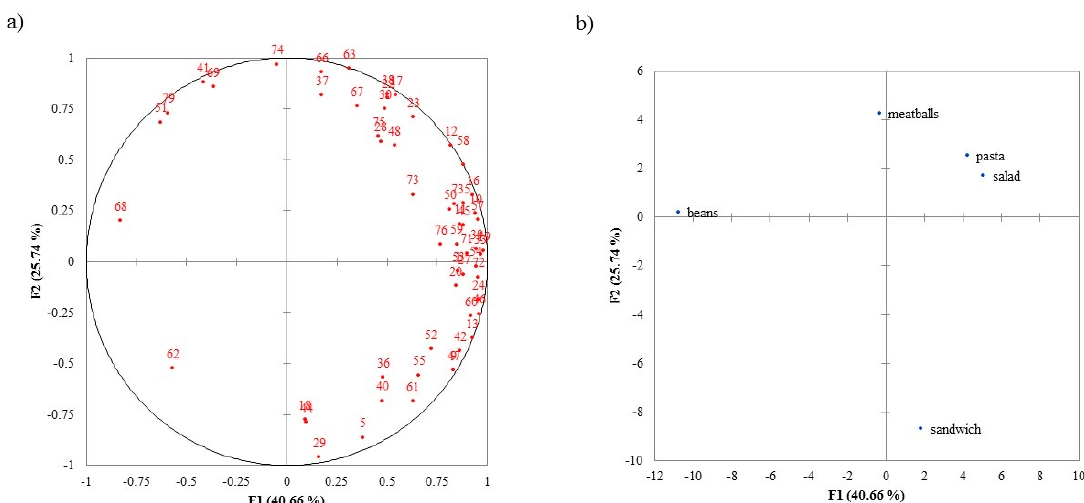
Figure 3. Internal preference map of consumer liking scores in the Pack Alone condition: ( a ) consumers, ( b ) samples.